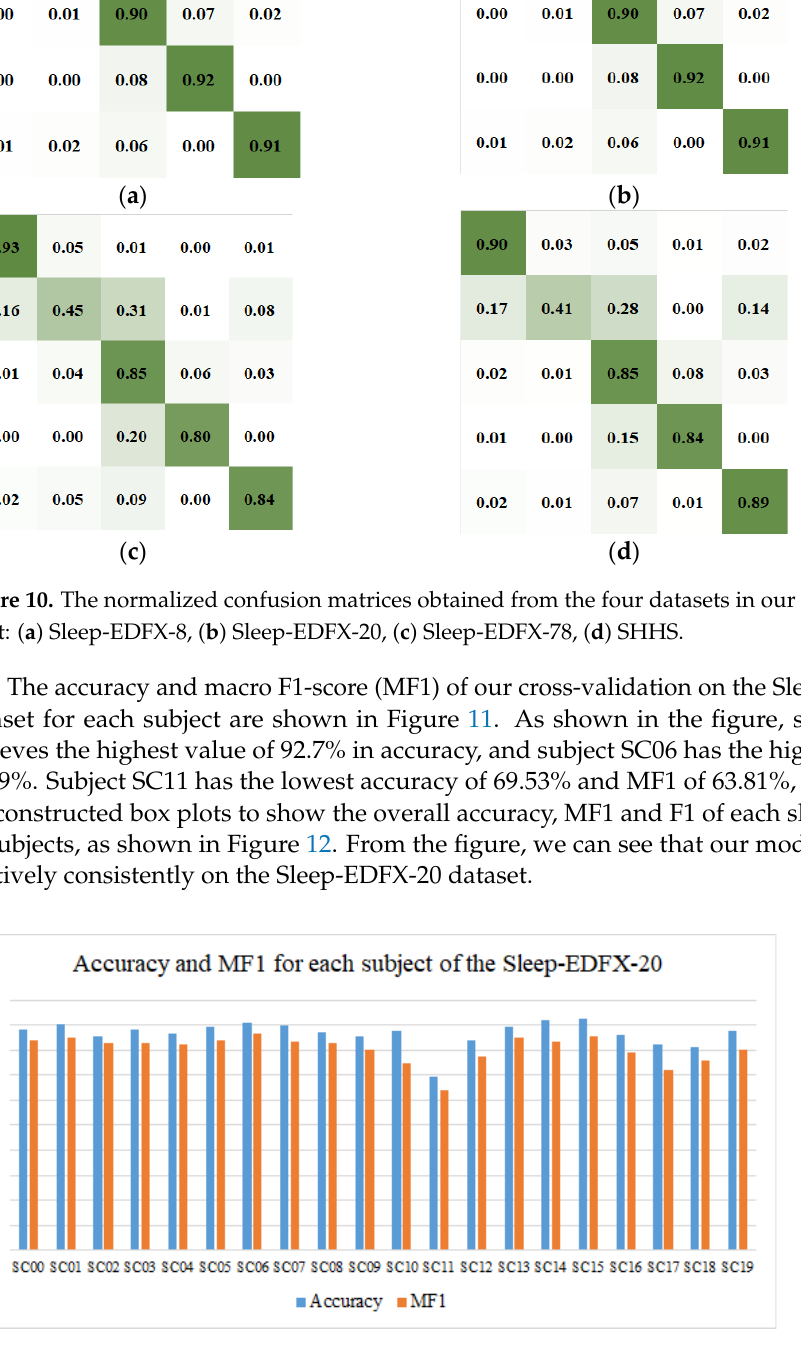
Table 5. Confusion matrix of Sleep-EDFX-78 dataset. Figure 11. Accuracy and MF1 for each subject using 20-fold cross-validation. Figure 11. Accuracy and MF1 for each subject using 20-fold